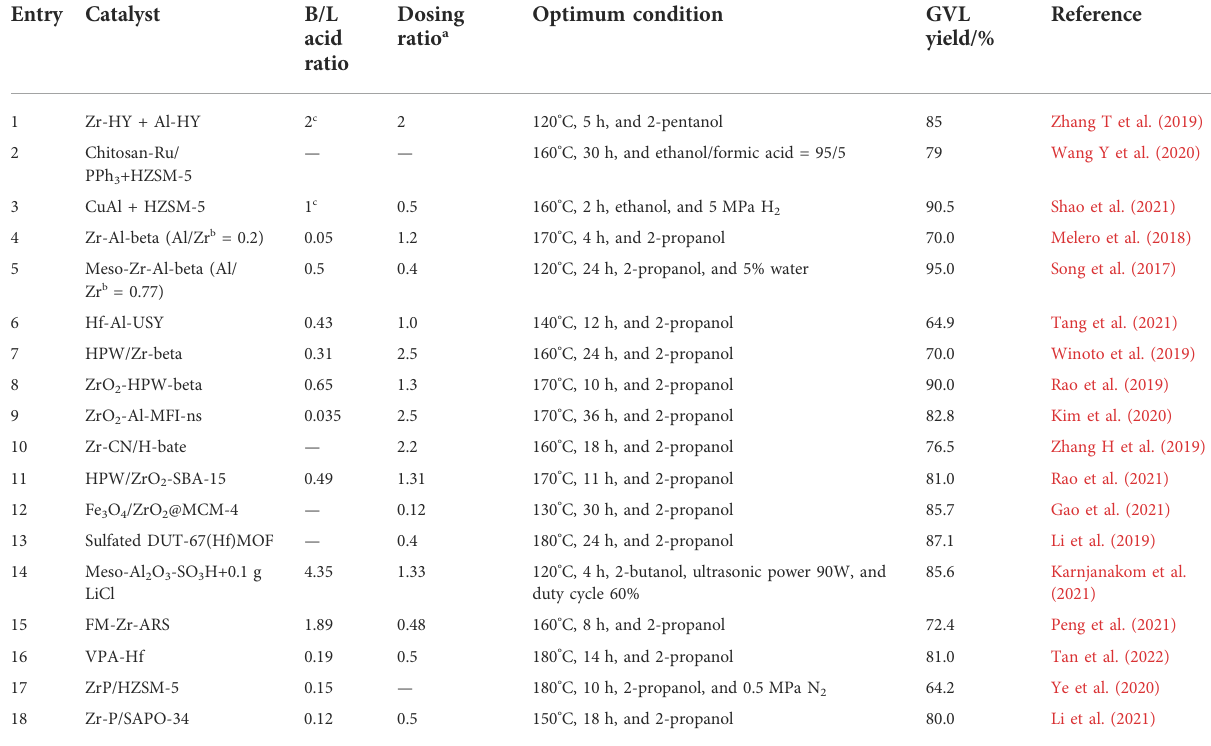
TABLE 1 Overview of important bifunctional catalysts for one-pot synthesis of GVL from